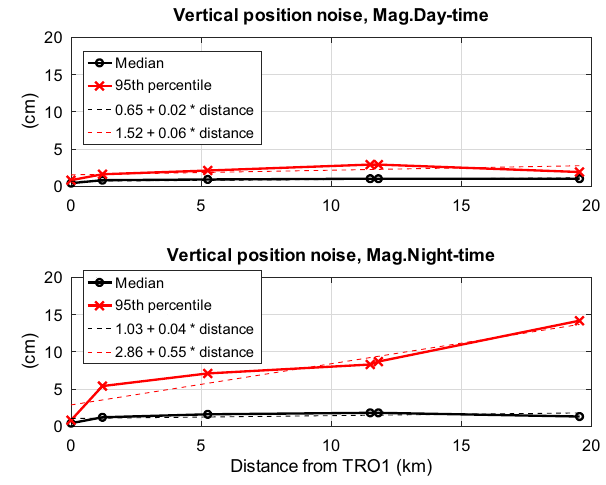
Fig. 12 Median and 95th percentile of vertical position standard deviation as a function of distance to the nearest network receiver, for magnetic day-time (top panel) and magnetic night-time (bot- tom panel). The dashed lines are linear fits, with the fitted param- eters reported in the